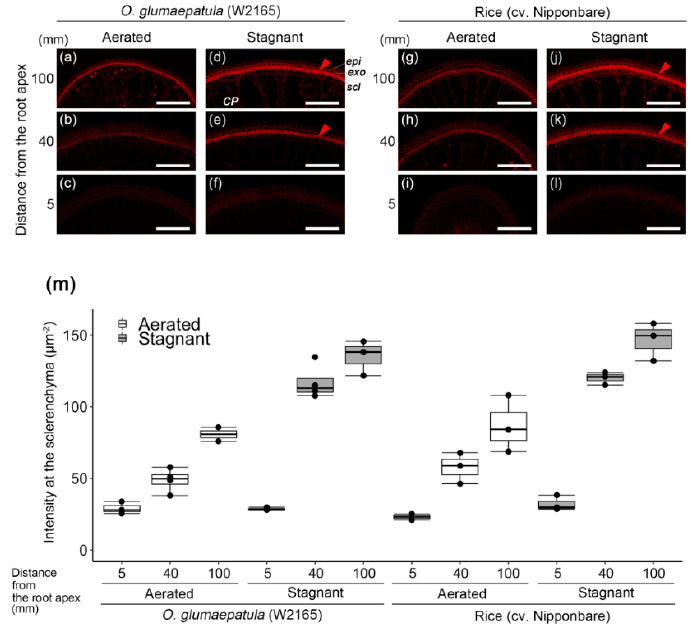
Figure 3. Lignification in the outer part of roots in accession W2165 of O. glumaepatula and rice (cv. Nipponbare) under aerated or stagnant conditions. Lignin deposits were observed in the basal parts (95–105 mm from the root apex; ( a , d , g , j ), middle parts (35–45 mm from the root apex; ( b , e , h , k ) and root tips (2.5–7.5 mm from the root apex; ( c , f , i , l ) of adventitious roots of 115–120 mm length. Lignin is indicated as red fluorescence with Basic Fuchsin (red arrowhead, mean of intensity value > 110.0 µ m − 2 ). Plants were grown in aerated nutrient solution for eight days and then transferred to deoxygenated stagnant 0.1% agar solution or continued aerated solution for 13–15 days. CP , cortical parenchyma; epi , epidermis; exo , exodermis; scl , sclerenchyma. Scale bars: 100 µ m. ( m ) Fluorescence intensity of Basic Fuchsin at the sclerenchyma under aerated (white box) or stagnant (grey box) conditions. Black dots indicate each raw value. n =